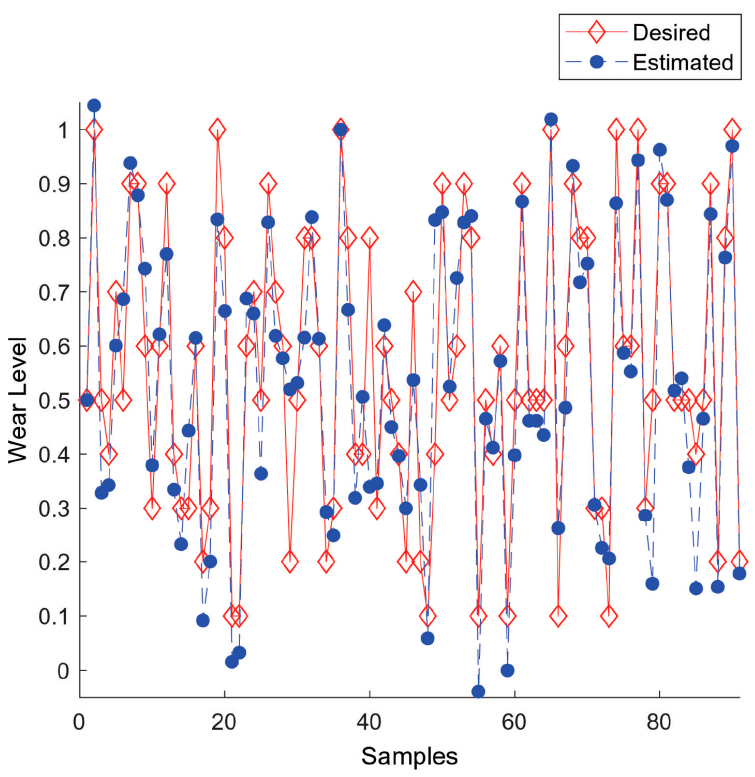
Energies 2020 , 13 , x FOR PEER REVIEW Figure 8. Neural estimator—wear evolution of a bearing fault—Line connect. Figure 8. Neural estimator—wear evolution of a bearing fault—Line connect.